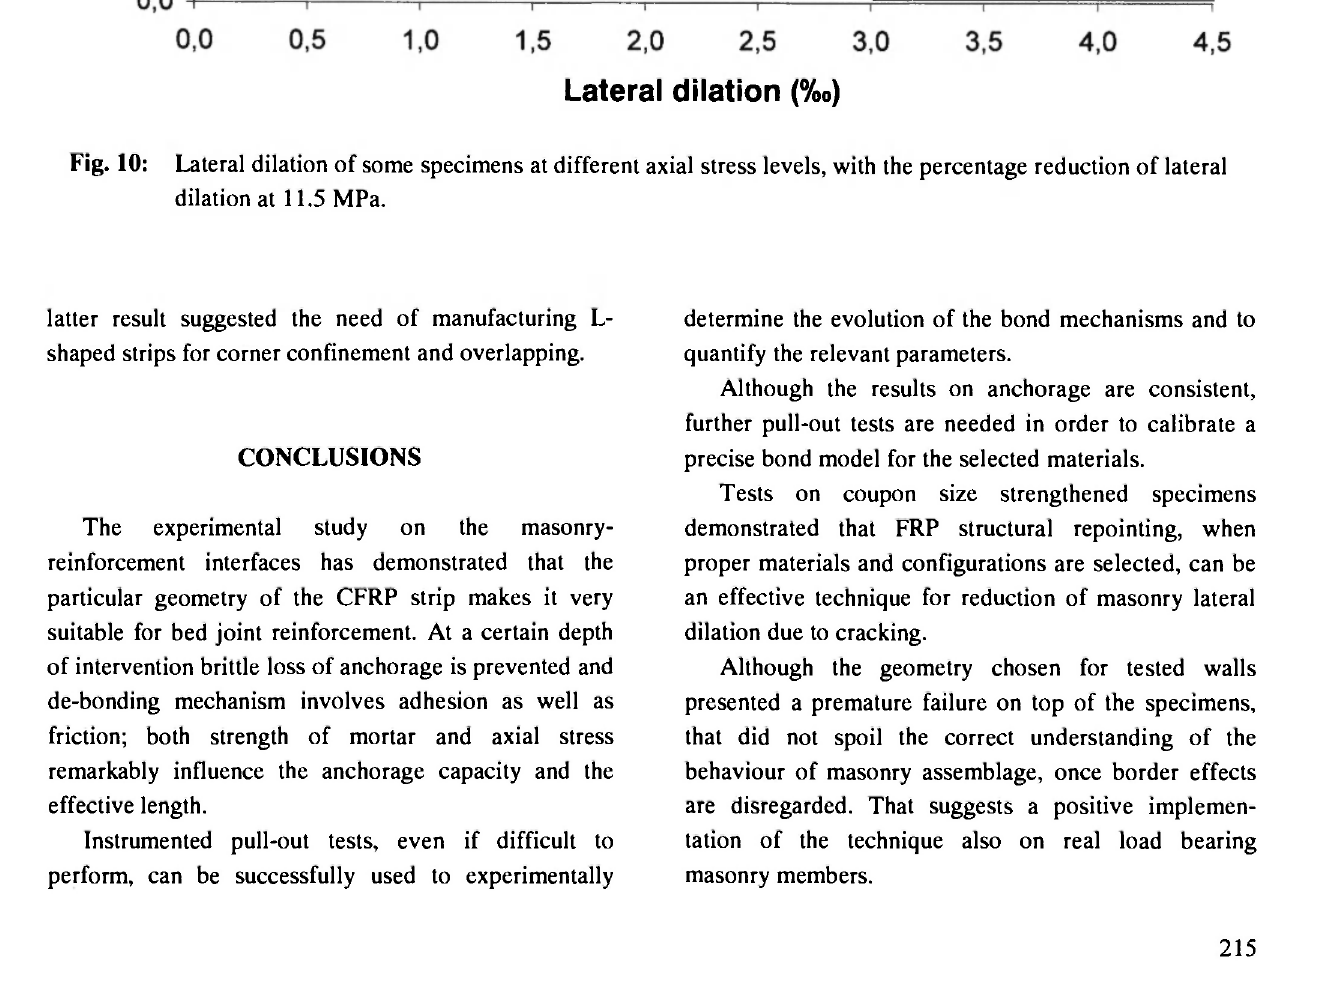
Fig. 10: Lateral dilation of some specimens at different axial stress levels, with the percentage reduction of lateral dilation at 11.5